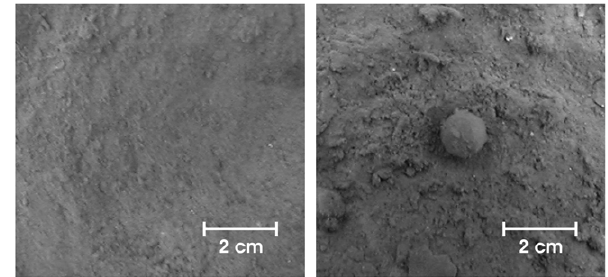
Figure 2. Photograph of the sediment surface of two push- cores. Control core (left picture) and sponge core with Tentorium semisuberites (right picture).